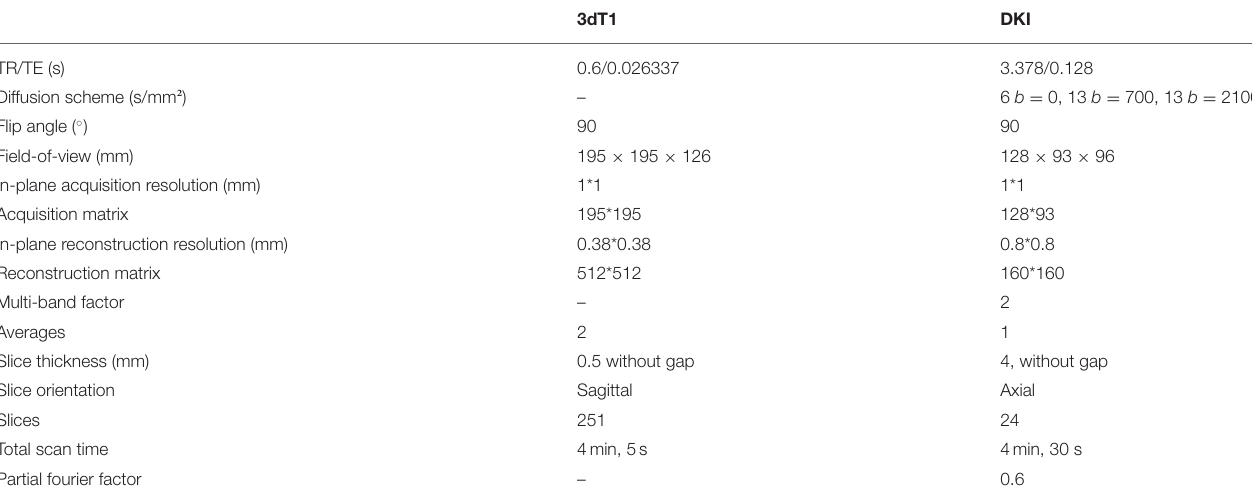
TABLE 2 | Data acquisition details for both structural 3D T1w and DKI